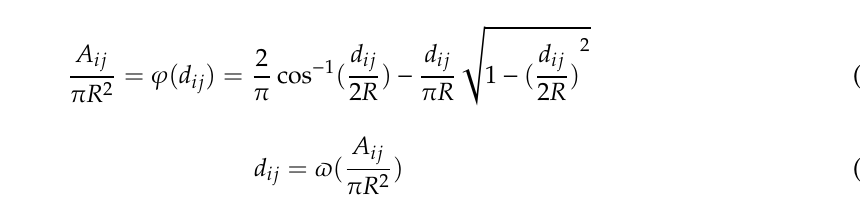
Figure 2. Communication between two nodes with one hop.